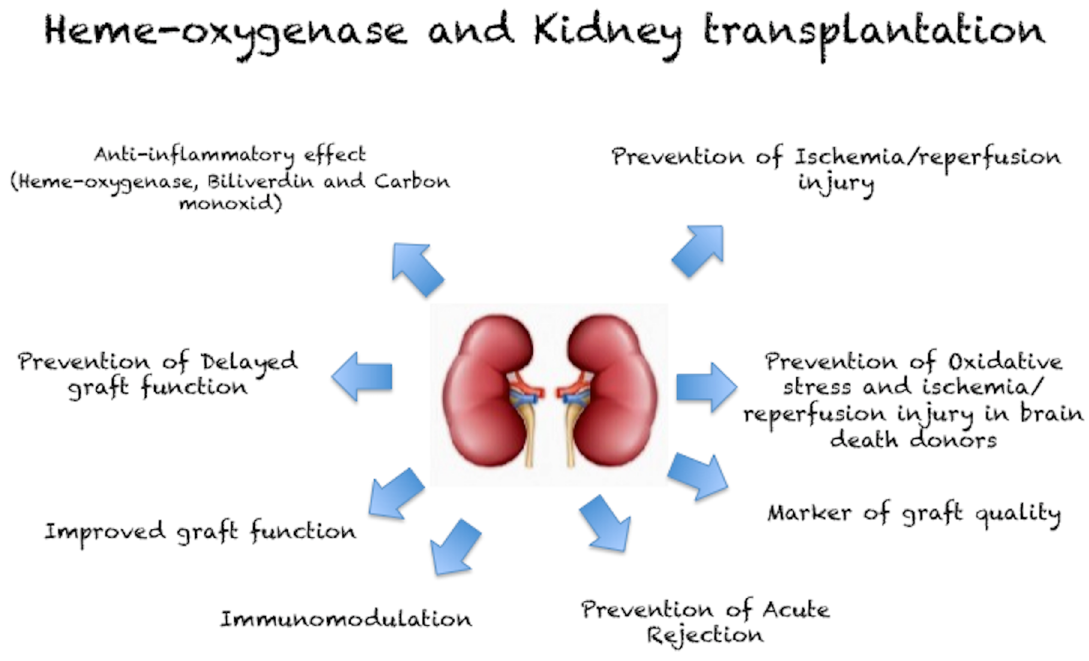
ff ect of heme-oxygenase in kidney Figure 4. Effect of heme-oxygenase in kidney transplantation. Figure 4. E